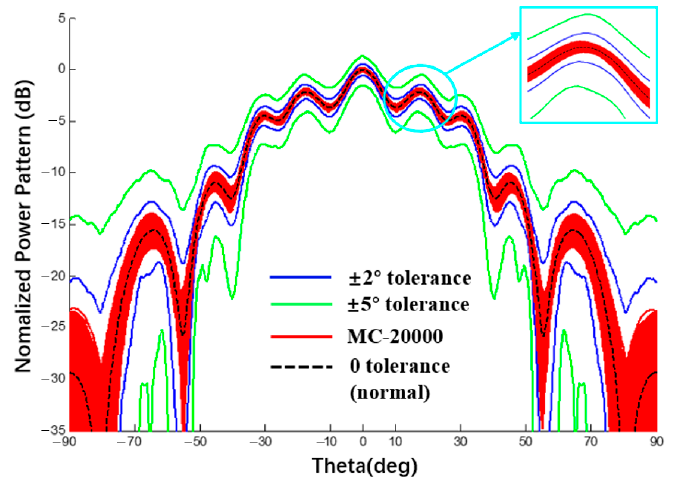
Figure 16. Power pattern under different excitation phase tolerances (Plane E, Dolph–Chebyshev excitation, the tolerance of MC method is ±2°).